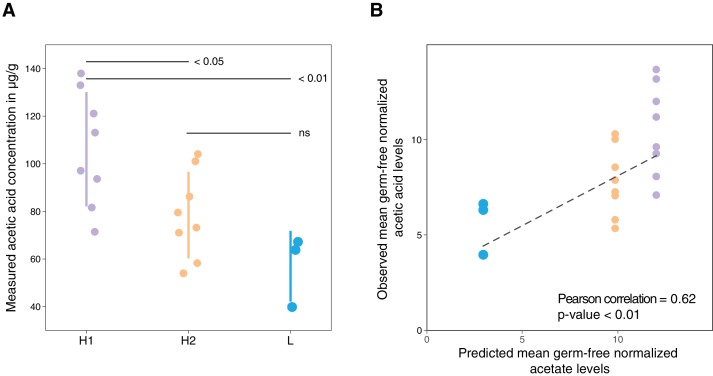
Metabolic profiling of three selected microbial consortia and comparison of predicted and measured metabolic profiles of three selected microbial consortia. (A) Metabolic profiling results of fecal content of selected consortia with respect to acetic acid. (B) Comparison of predicted mean germ-free normalized acetate concentrations based on single-strain measurements in caecal content from (Atarashi et al., 2013) with the observed germ-free mean normalized acetic acid levels in mouse stool from (A).